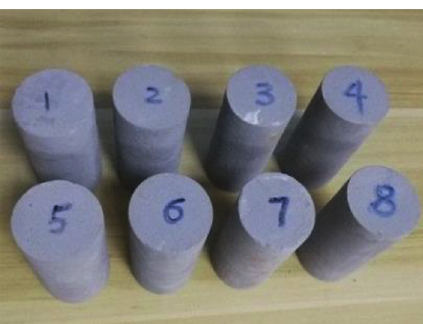
Figure 7: Partial backfill